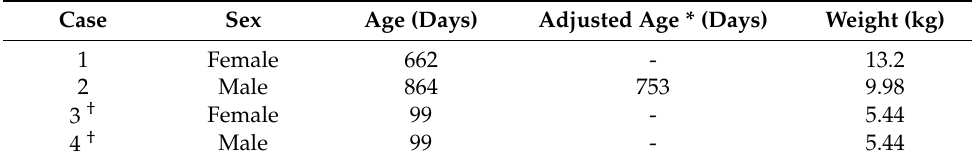
Table 1. Demographic Information at Visit 1 (Week